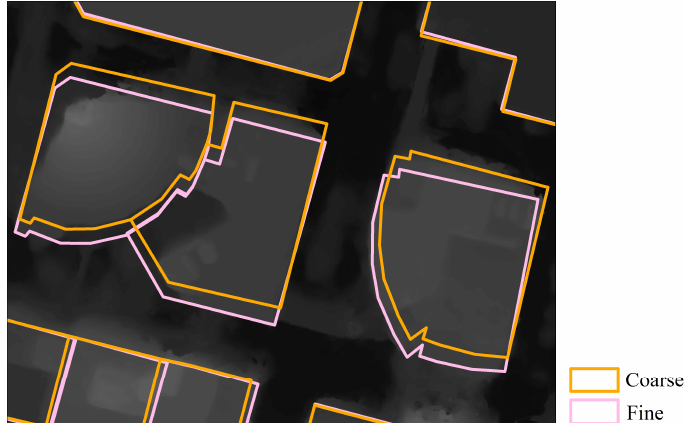
Figure 6. The effect of the fine registration.